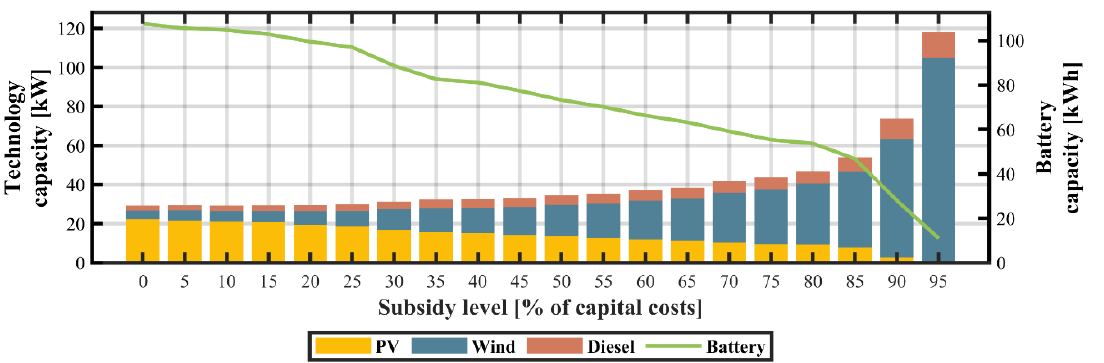
Figure 14. Simulation results of capital subsidies for wind technologies. Impact on the capacity of DG technologies.